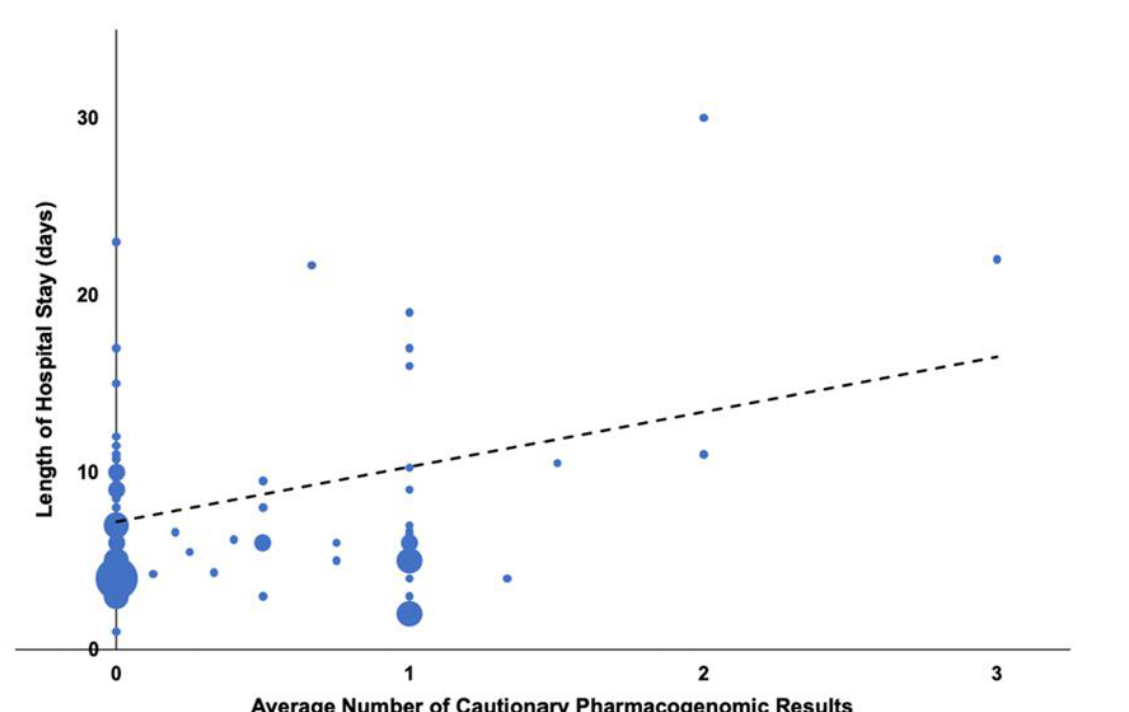
Figure 2. Cautionary pharmacogenomic results available for newly prescribed medications during hospitalizations. There was a positive relationship between the per-patient average number of cautionary pharmacogenomic results associated with newly prescribed medications during hospitalizations and length of hospital stay; however, the correlation was modest, r (71) = 0.33, p < 0.01 Pearson’s r. Since this correlation may have been driven by a small number of patients with a higher number of cautionary pharmacogenomic results, we repeated the analysis using Spearman’s rank correlation test, which may provide a more robust assessment in the presence of outliers, and we observed a small non-significant correlation ( ρ = 0.09, p = 0.44).